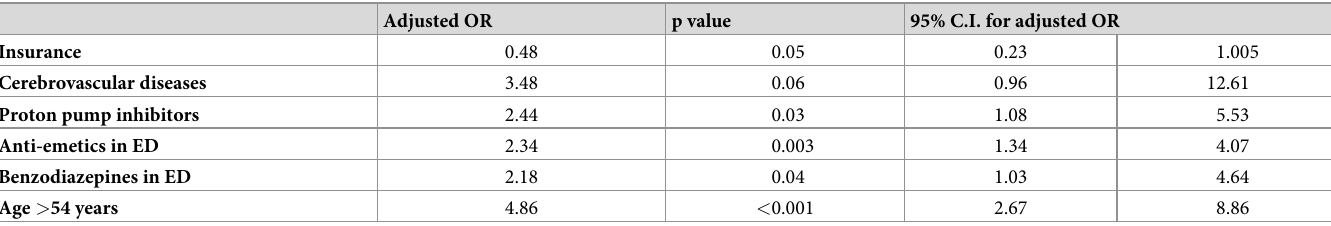
Table 5. Logistic regression: Factors associated with hospital